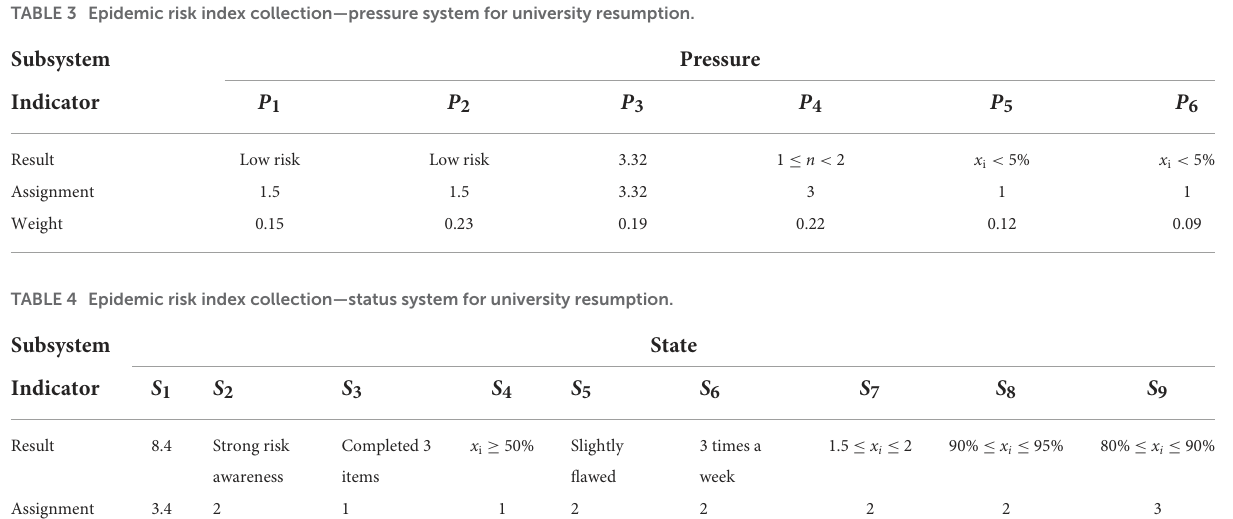
TABLE 3 Epidemic risk index collection—pressure system for university resumption.